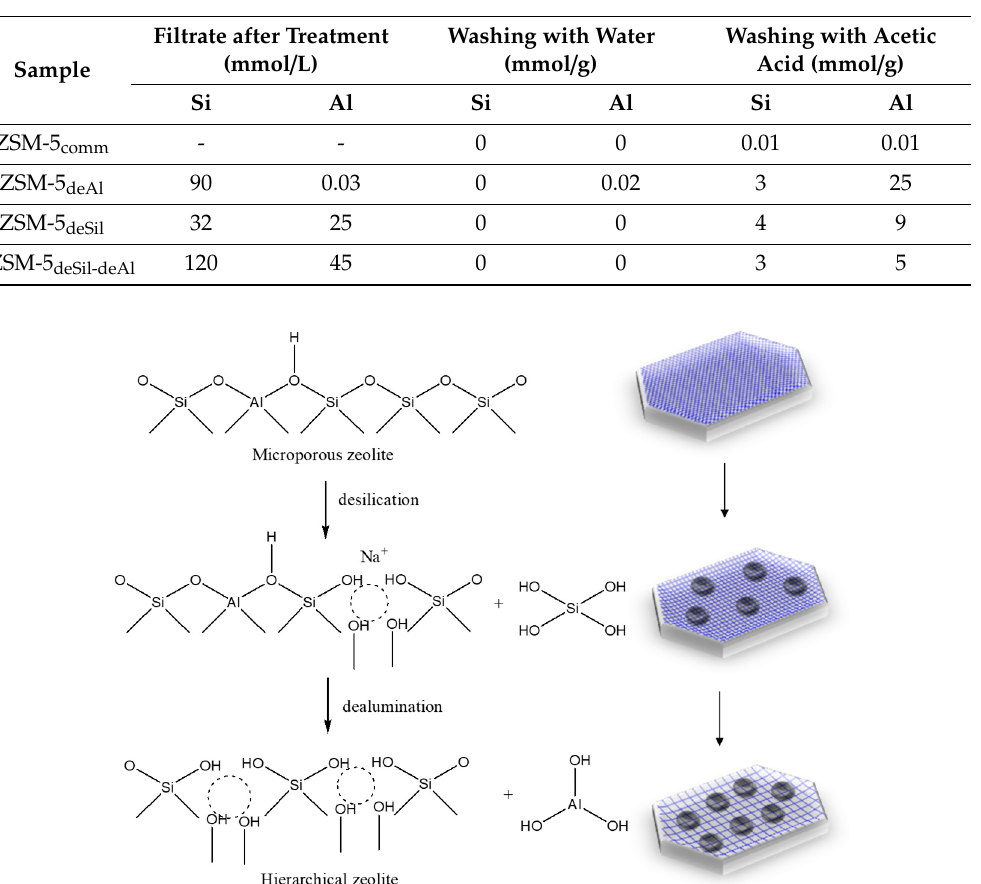
Figure 3. Transformation from microporous to hierarchical ZSM-5 (dotted circle refers to new porosity formation).